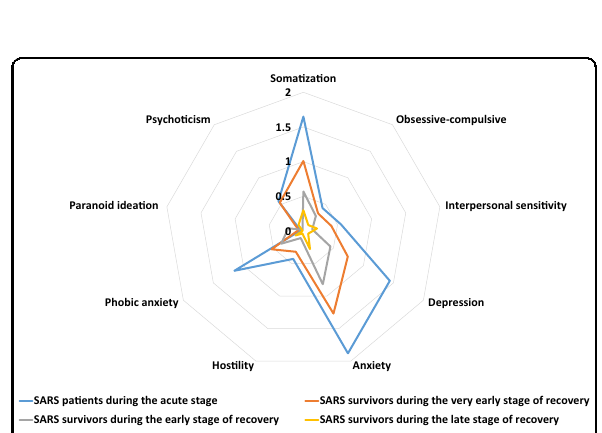
Fig. 3 Severity of psychiatric symptoms of SARS patients and survivors. Radar map depicting the severity of psychiatric symptoms of SARS patients and survivors, as measured by Cohen ’ s d